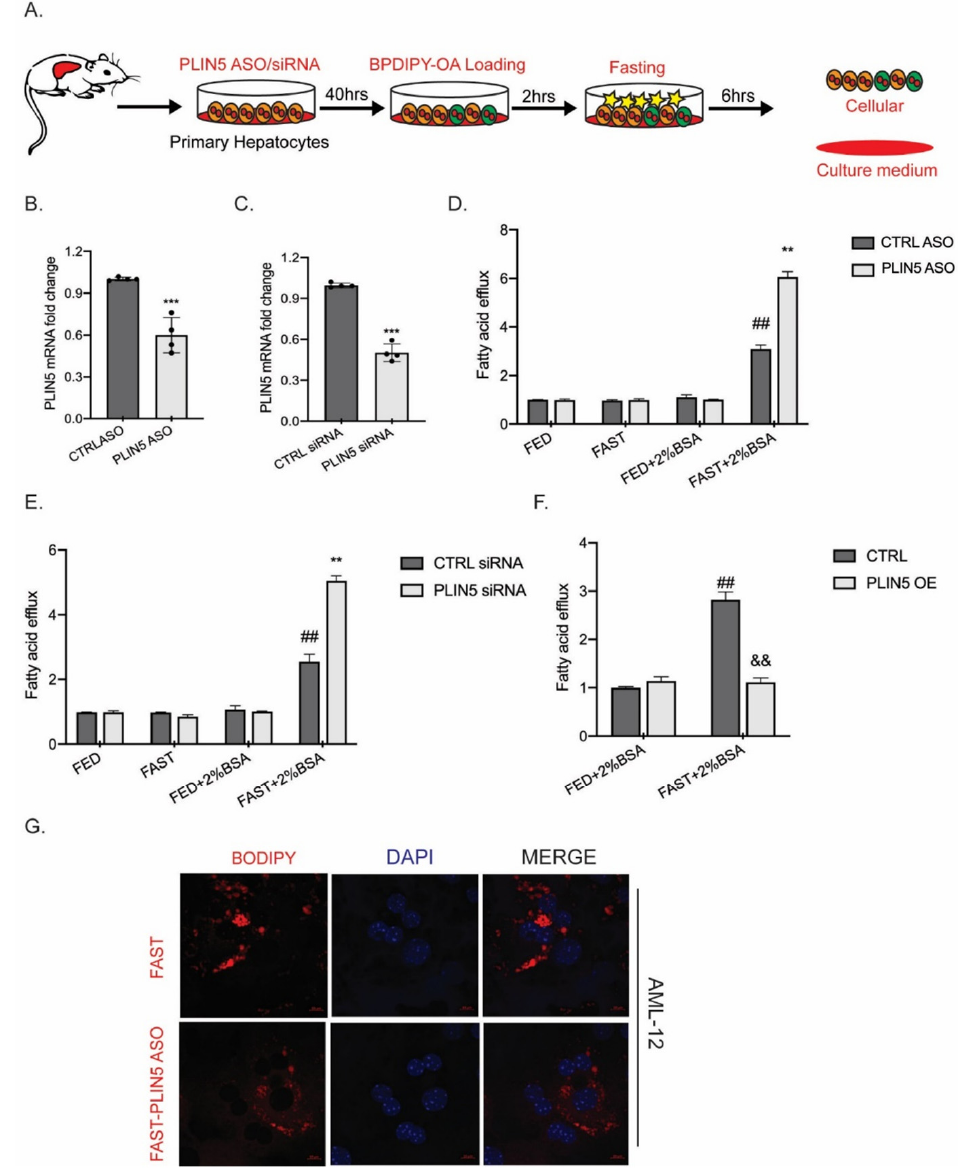
Figure 1. Deficiency of PLIN5 decreases LD accumulation by increasing fatty acid efflux. ( A ) Sche- matic diagram of pulse-chase experiment for measuring FA efflux using BODIPY-conjugated [ 14 C] OA. ( B , C ) mRNA abundance of PLIN5 in primary mouse hepatocytes transfected with or without ASOs (0.5 μ g/mL for 48 h) ( B ) and treated with or without RNA interference ( C ). ( D , E ) In the pres- ence or absence of BSA, the effect of PLIN5 ASO ( D ) or PLIN5 siRNA ( E ) on FA efflux of primary mouse hepatocytes under FED or FAST media conditions. ( F )Effects of PLIN5 overexpression on FA efflux with BSA present in the media. ( G ) Representative images of BODIPY stained intracellu- lar LDs under FAST or FAST-PLIN5 ASOs in AML12 mouse liver cells. Scale bars: 10 μ m. ** p < 0.01, *** p < 0.001 vs. CTRL. For ( D , E ), ** p < 0.01 vs. CTRL-ASO or CTRL siRNA. ## p < 0.01 vs. FED + BSA. && p < 0.01 vs. CTRL.